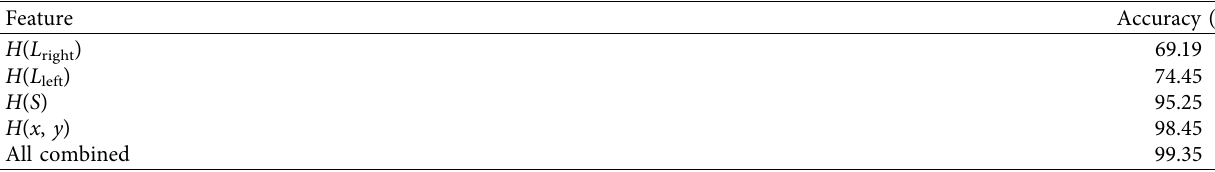
Table 4: Classification accuracy of different features.